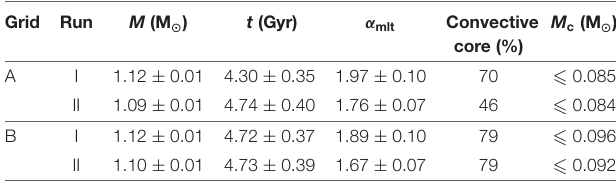
TABLE 3 | Stellar parameters determined using different grids and observational constraints. Grid Run